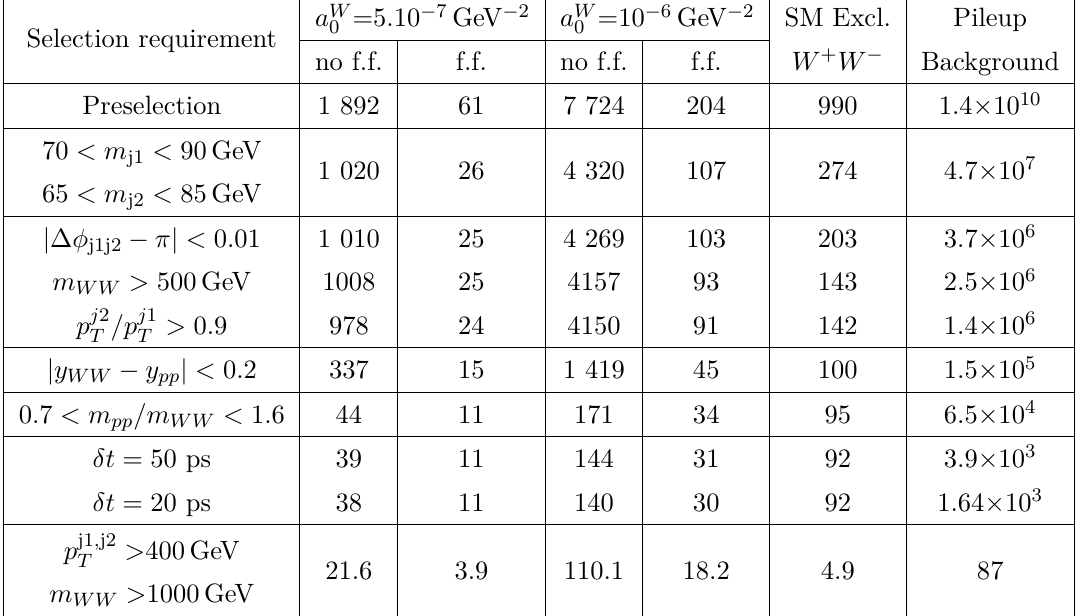
Table 4 . Number of events at 300 fb − 1 after each sequential selection criterion for anomalous exclu- sive W + W − production with and without form factors ( a W